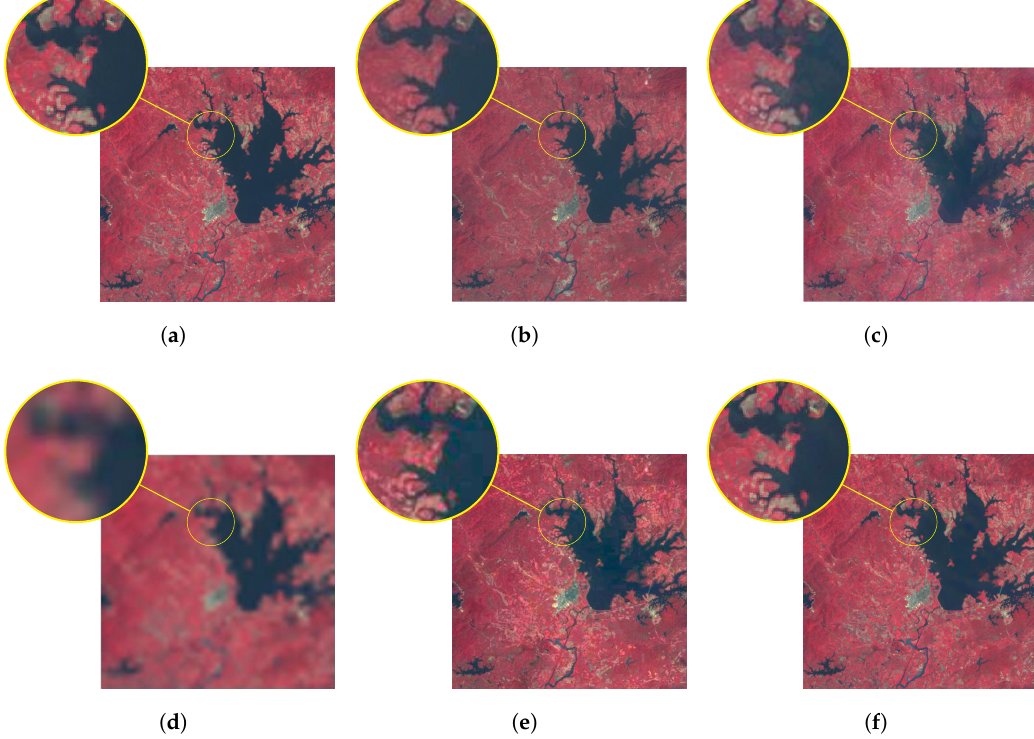
Figure 11. Predicted results of phenology changes images: ( a ) the actual Landsat image; ( b ) predicted result of STARFM; ( c ) predicted result of SPSTFM; ( d ) predicted result of SRCNN; ( e ) predicted result of FSDAF; ( f ) predicted result of MDBFM. Table 4. Index analysis of data with phenology